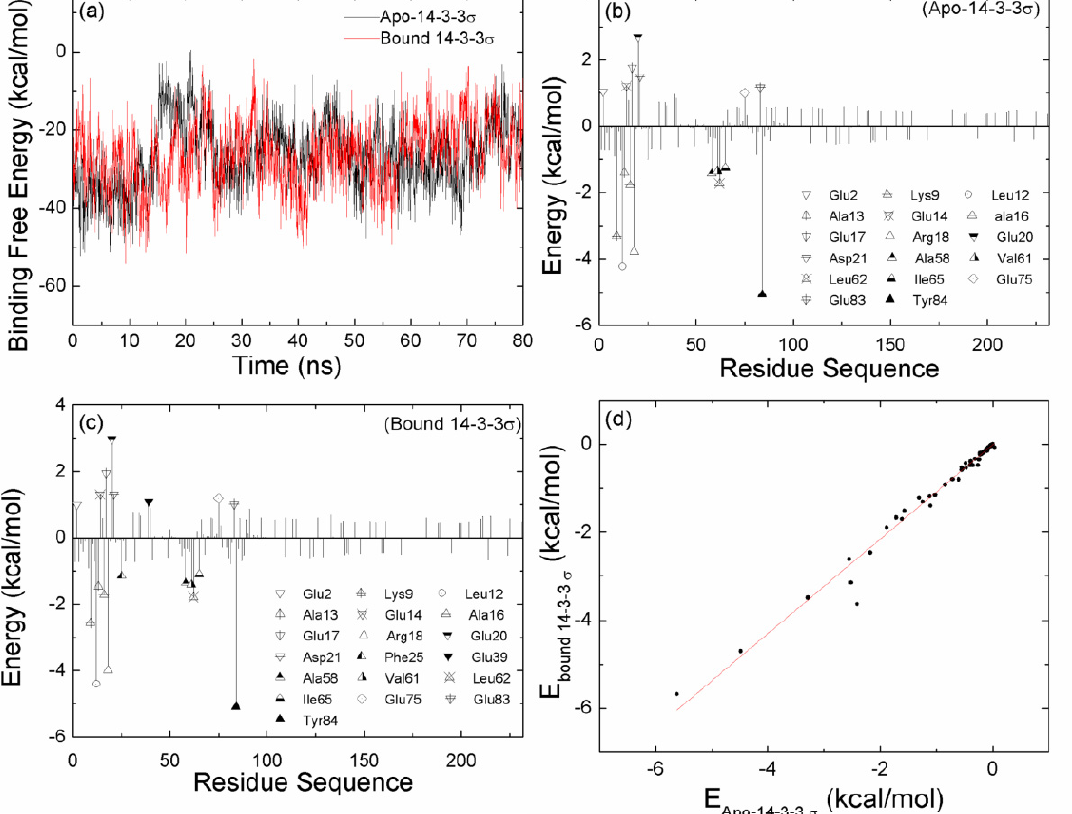
), sum of vdW + G ) and the ele pol